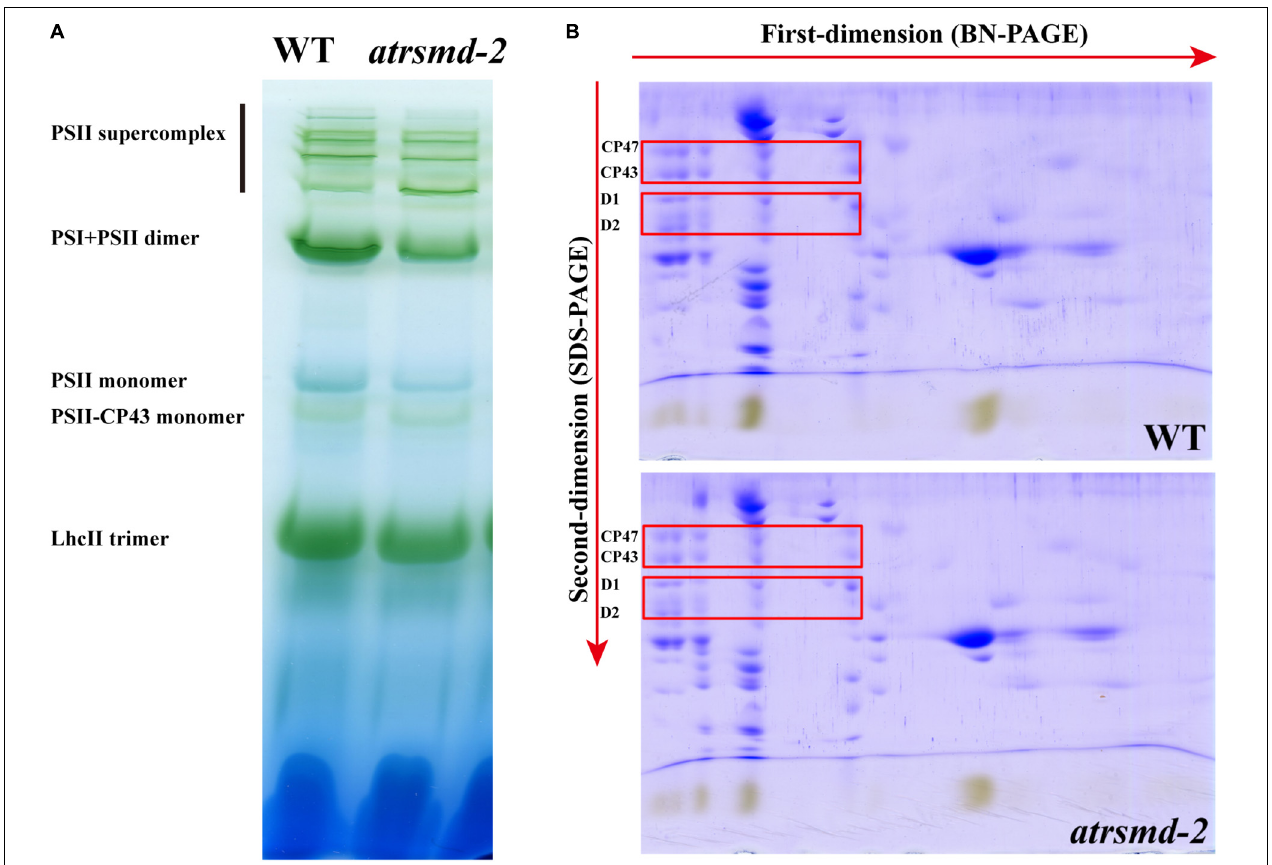
FIGURE 3 | Analysis of photosystem complexes from the wild-type and atrsmd-2 mutant grown under normal growth conditions. (A) BN-gel analysis of the thylakoid membrane protein complexes in the wild type (WT) and the atrsmd-2 mutant. Representative unstained BN-PAGE gel electrophoresis is shown. Thylakoid membranes from the wild type (WT) and atrsmd-2 mutant were solubilized with 1% DM and separated by native PAGE. A sample with an equal amount of chlorophyll (16 µ g) was loaded in each lane. The bands for supercomplexes are marked on the left. (B) 2-D, BN/SDS-urea-PAGE analysis of the thylakoid membrane complexes. Thylakoid complexes were separated by BN-PAGE and further subjected to 2D SDS–PAGE. The gels were stained with Coomassie Brilliant Blue. The locations of the plastid-encoded core proteins of PSII (CP43, CP47, D1, and D2) are indicated by red boxes on the gels, following to a previous report (Li et al.,